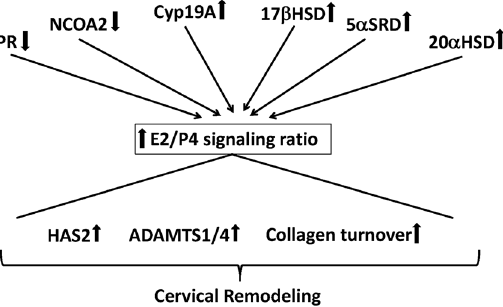
Figure 8. The “bow-tie architecture” of cervical remodeling explaining inter-species variation in gene expression. In this model it is assumed that there exists a conserved core regulatory mechanism controlling the expression of genes affecting the cervical extracellular matrix. This core mechanism is assumed to monitor the relative strength of E to P4 signaling and translates this signal into expression differences in ECM genes. Exactly which genes are regulated to change cervical ECM varies between species (not shown). In addition, genes that affect E and P4 signaling are different among species but all these different expression patterns likely increase the E/P4 signaling ratio towards term. The multiple ways to achieve the same outcome, E/P4 increase, can explain why the regulation of cervical ripening can differ from species to